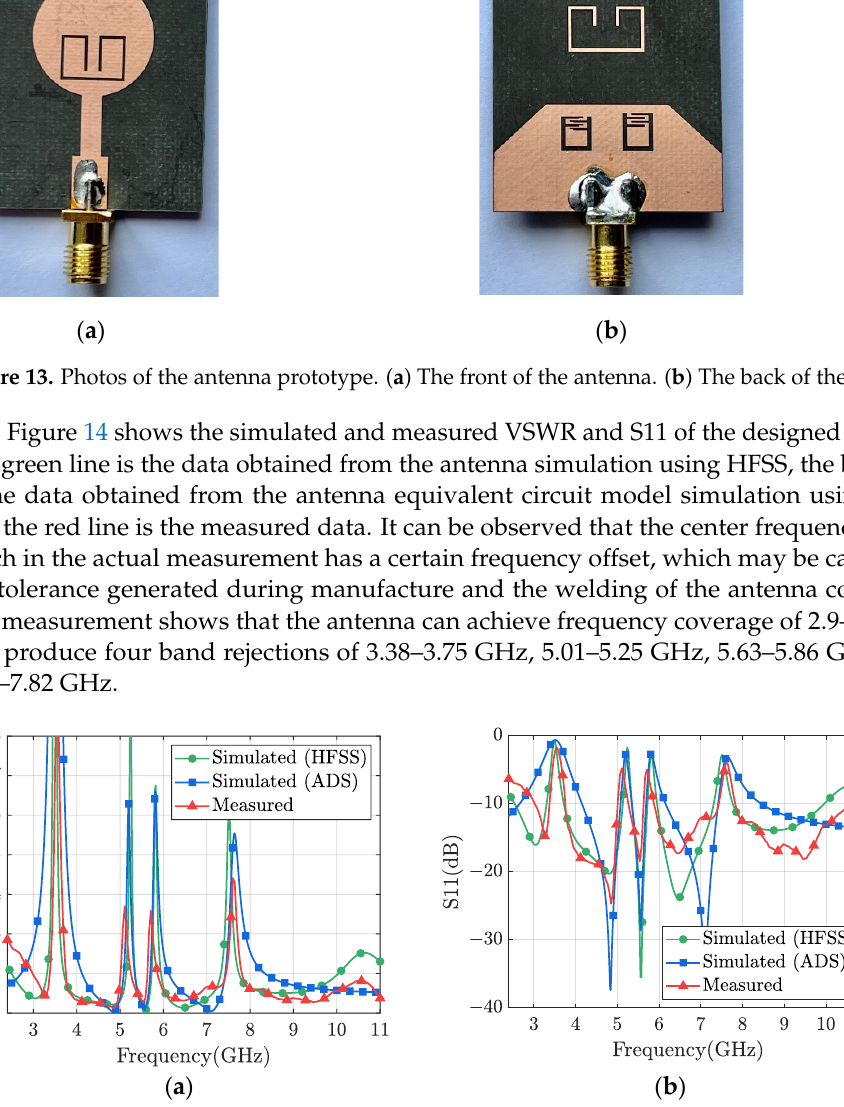
Figure 14. Simulated and measured of the proposed antenna. ( a ) VSWR. ( b ) S11.